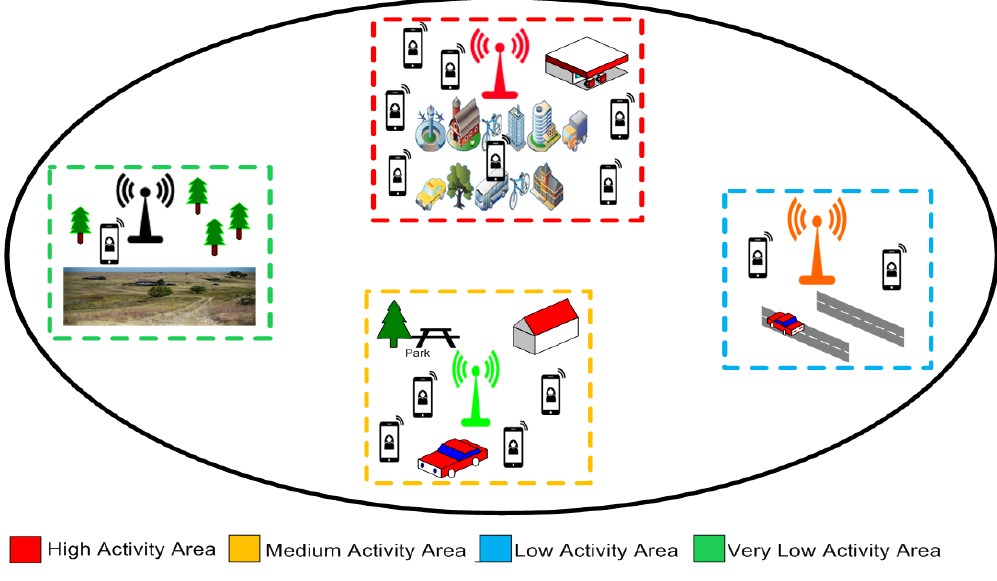
Figure 1. Overall